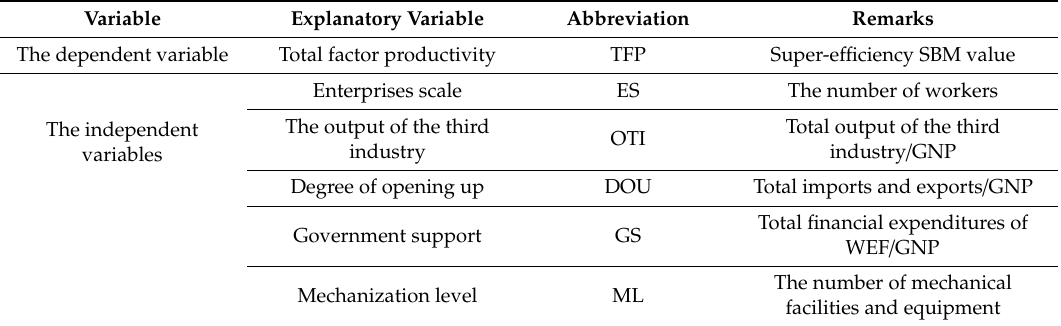
Table 6. The explanatory variable, abbreviation and remarks of influential factors of the